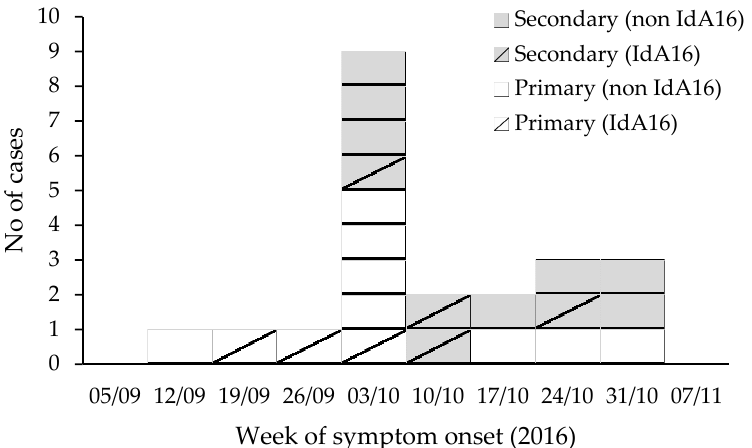
Figure 1. Distribution of outbreak-associated Cryptosporidium cases (and gp60 subtype) by week of onset of symptoms, North East England, 2016 (n = 22).